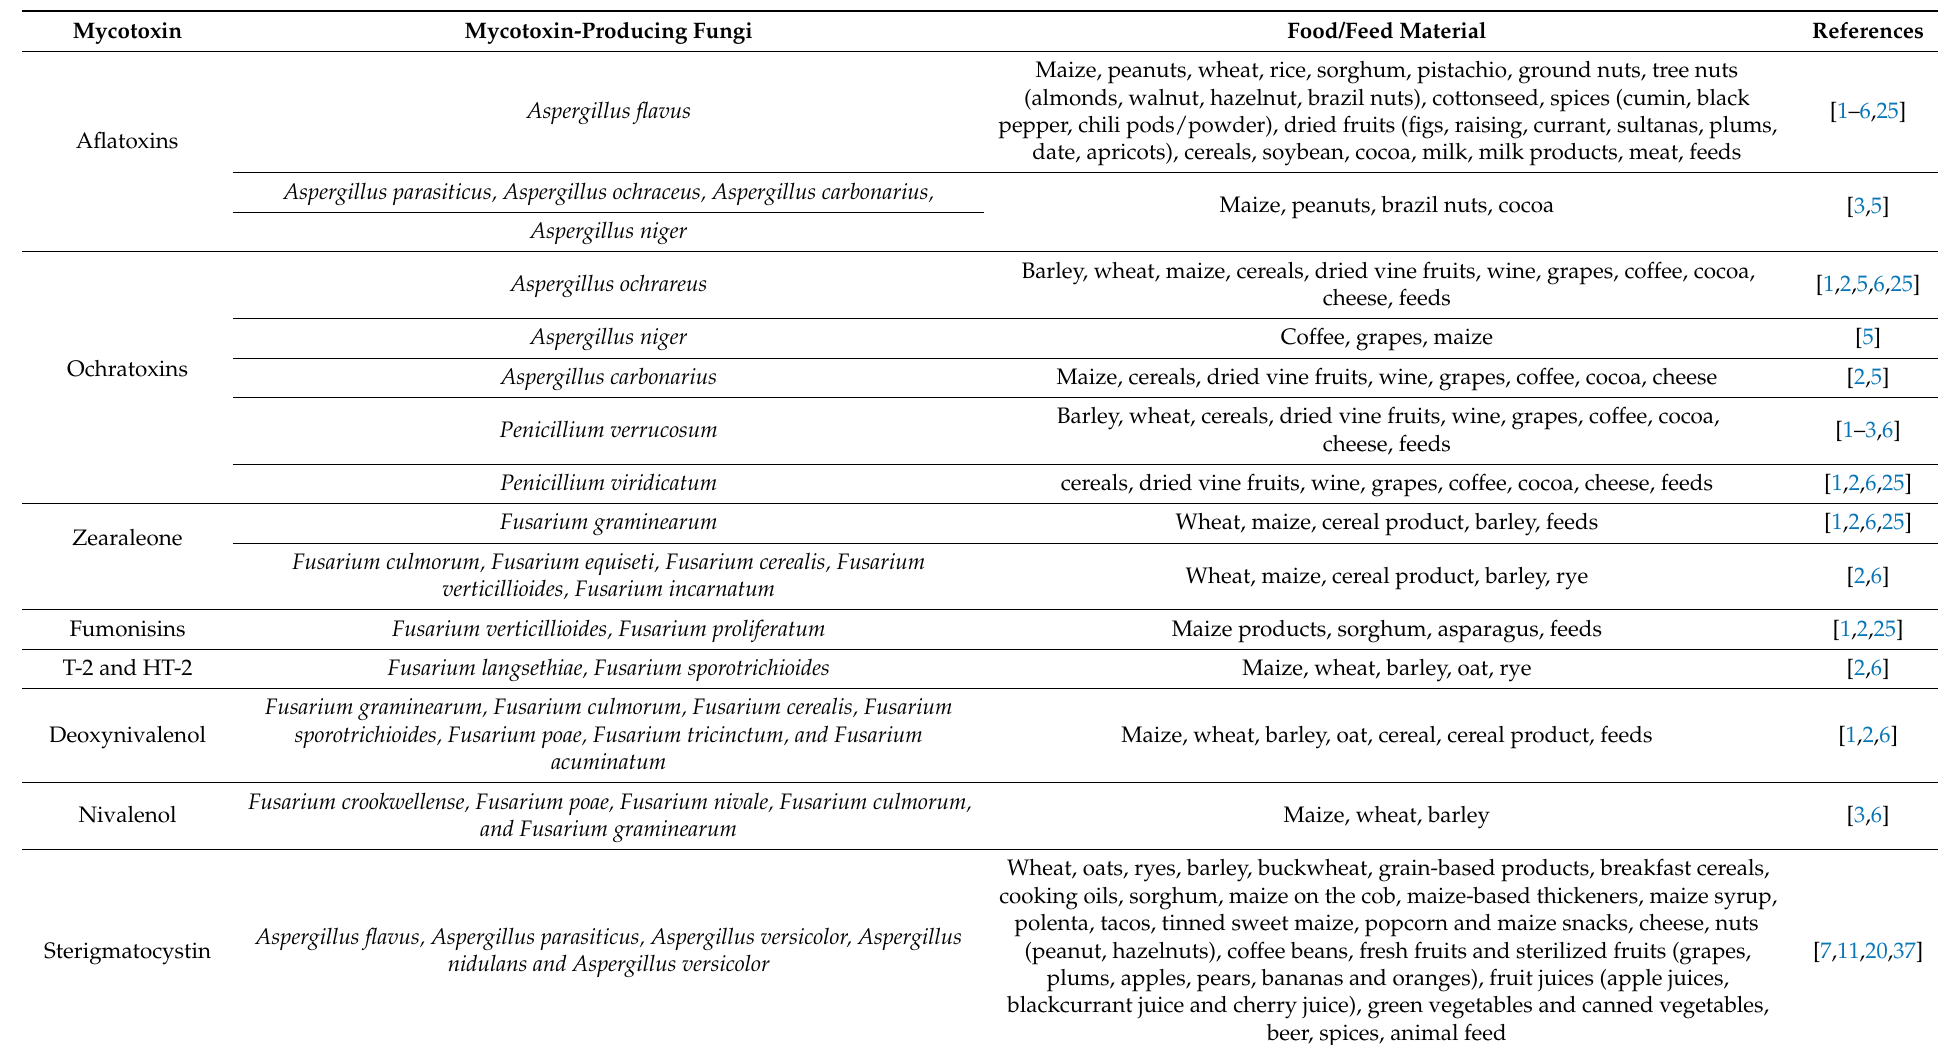
Table 1. Selected mycotoxins, producing fungal species, and contaminated